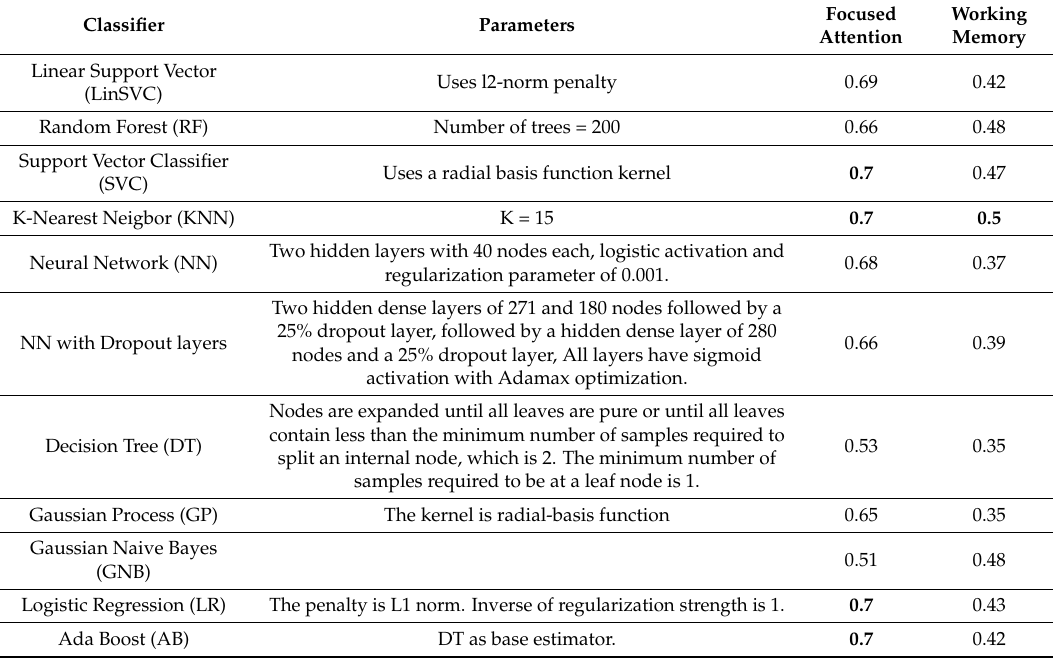
Table 1. Summary of the average scores of stratified 10-fold cross validation for the two cognitive skills using only frequency-domain features. Highest scores are shown in bold.